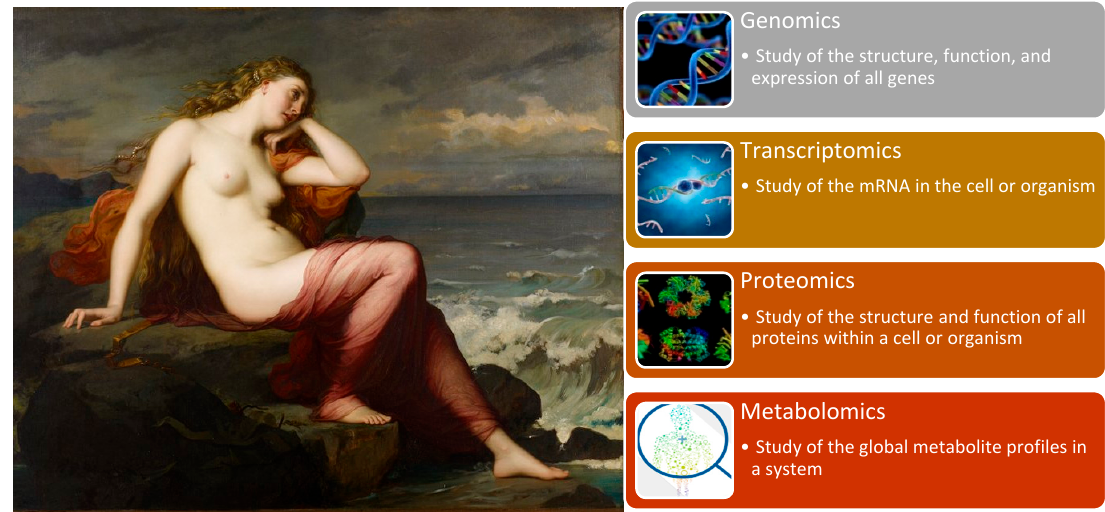
Figure 10. Calypso staring at the four most common “-omics” studies.